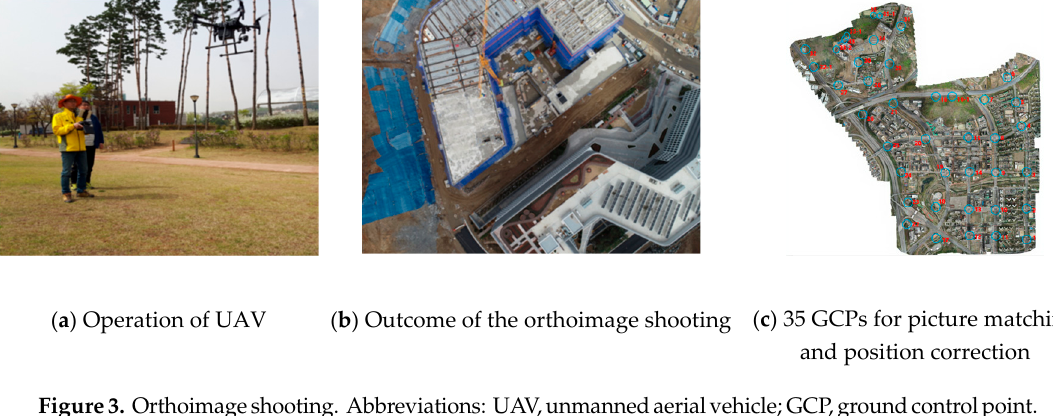
Figure 3. Orthoimage shooting. Abbreviations: UAV, unmanned aerial vehicle; GCP, ground control point.